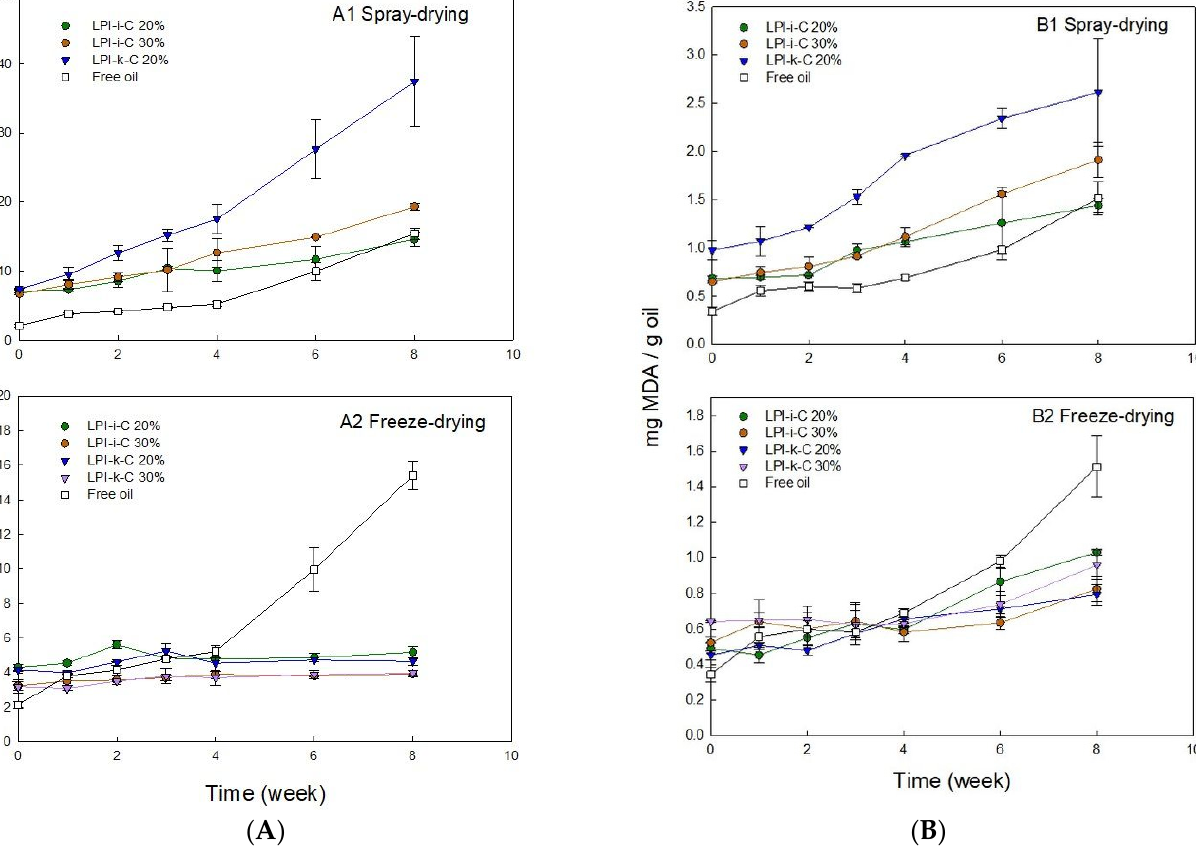
Figure 3. Changes in ( A ) peroxide value (PV) and ( B ) 2-thiobarbituric acid reactive substances (TBARS) for the untreated and encapsulated flaxseed oil through spray-drying (1) and freeze-drying (2) over 8 weeks of storage at room temperature (21–23 °C). Note that untreated oil was not spray dried nor freeze dried. Both LPI 20% & 30% powders were not included in the oxidation tests as their corresponding emulsions rapidly destabilized after emulsification. The percentage on the name of the samples represents the final oil content in dried powders. The Y -axis is different between spray- and freeze-drying in order to show the trends. Data represent the mean ± one standard deviation ( n = 3). PV value of untreated flaxseed oil before the encapsulation process was 2.1